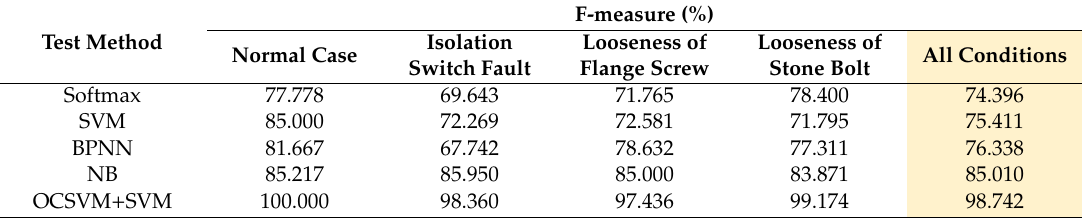
Table 5. F-measure of first experiment with di ff erent